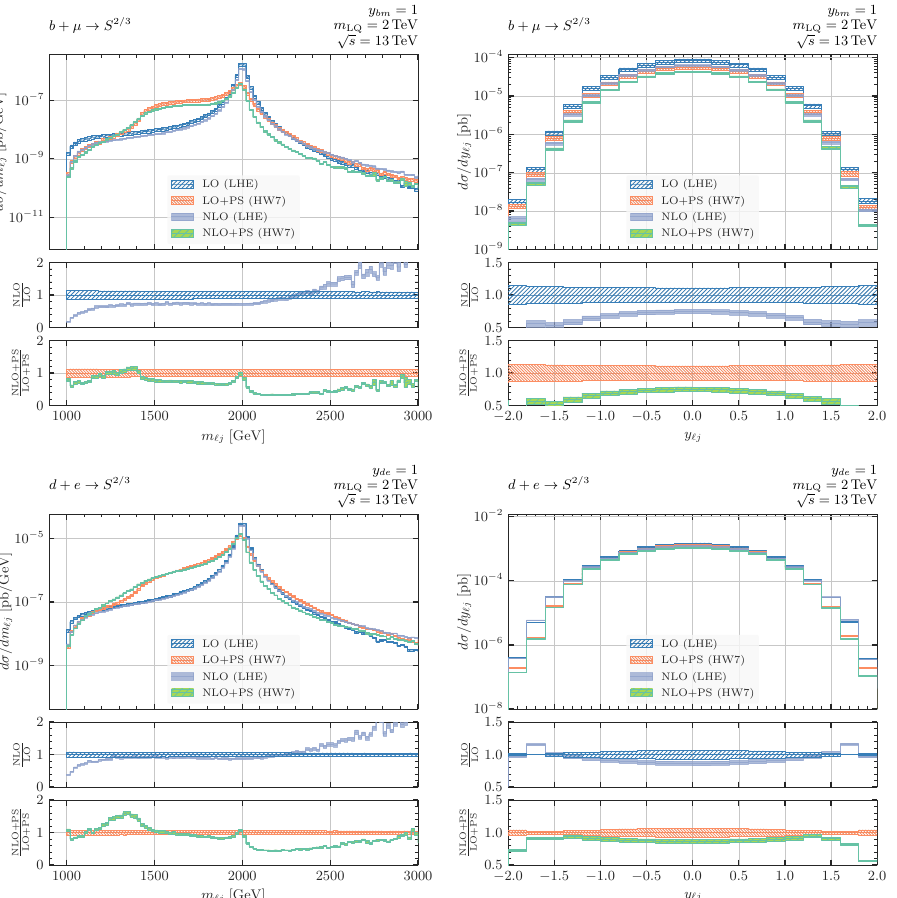
Figure 2 . Differential distributions for the benchmark points defined in section 3.2. The left (right) panel shows the jet-lepton system’s invariant mass